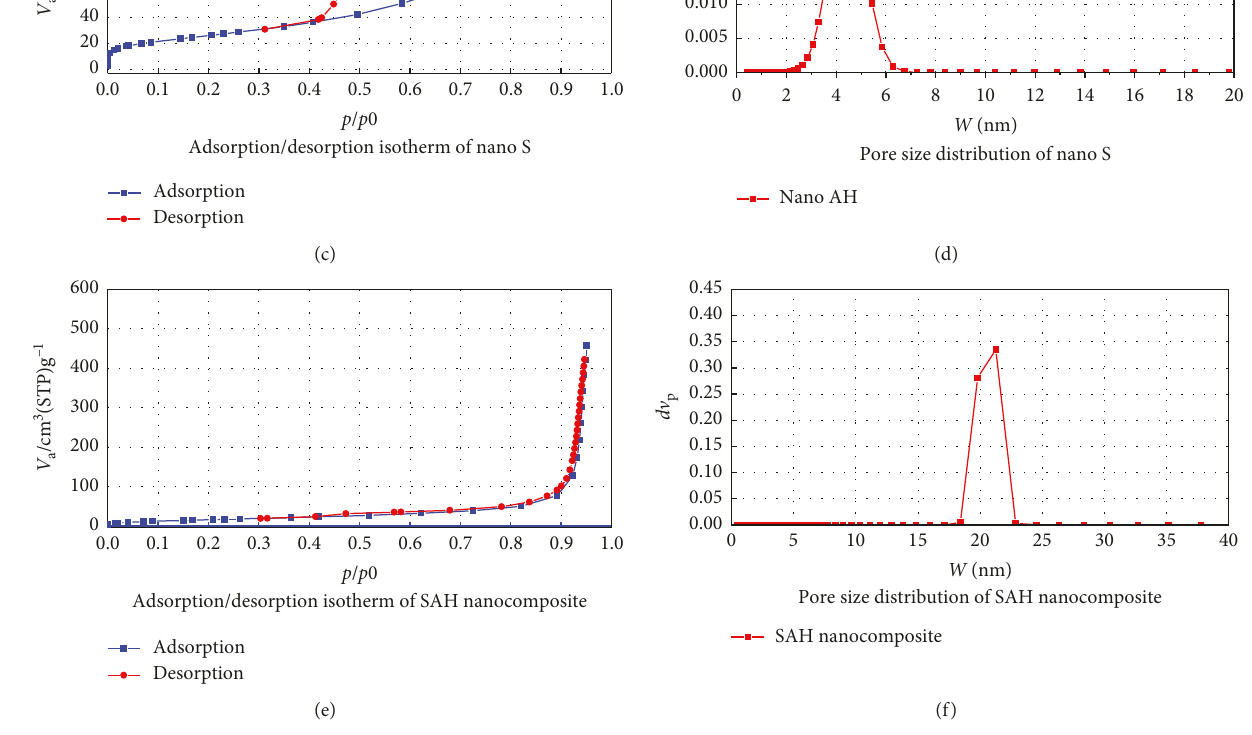
Figure 6: N 2 adsorption-desorption isotherms of (a) NS, (c) GNPs, and (e) the NSG nanocomposite and the pore size distribution curves of (b) NS, (d) GNPs, and (f) the NSG nanocomposite. Table 2: The data on surface area, pore volume, and average pore radius.